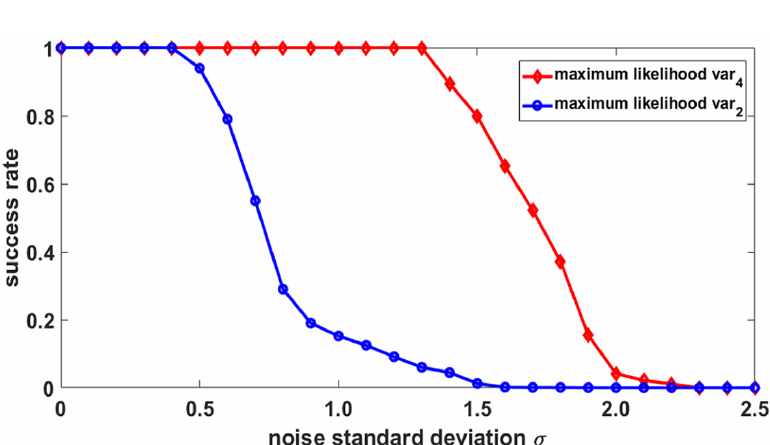
Figure 5. Success rate according to noise standard deviation (using maximum